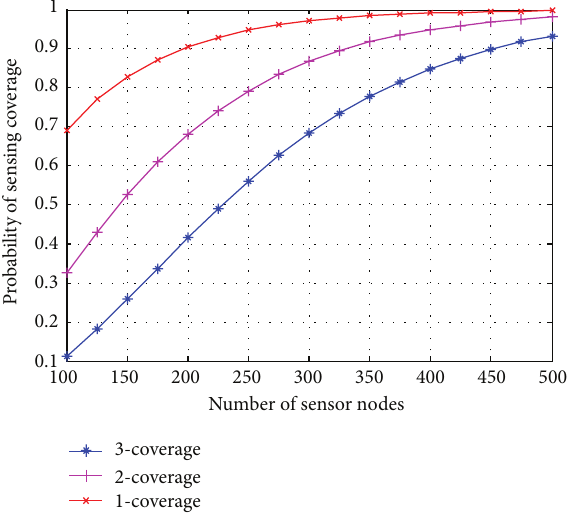
Figure 4: Probability of coverage versus sensor nodes, standard deviation 𝜎 = 4 .